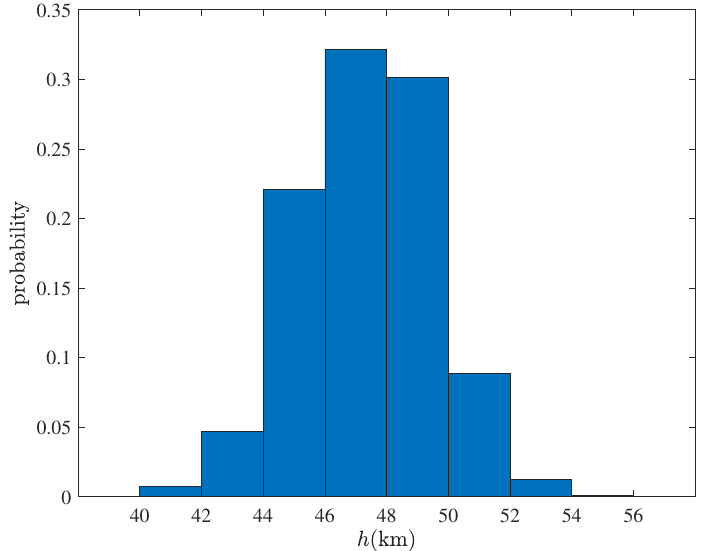
Figure 10. The histogram shows the distribution of altitude during orbit maintenance in the condi- tions of Ω = 240 ◦ , i = 27 ◦ and (cid:107) T (cid:107) = 20 mN. Comparing with the simulation with Ω = 240 ◦ , i = 3 ◦ the altitude of orbit more concentrates in the range from 44 km to 54 km. Due to differences in degree of stability, the effects of orbit maintenance in different inclinations are diverse. As shown in Figure 11, life maintenance time varying with initial inclination is exhibited with Ω = 240 ◦ and (cid:107) T (cid:107) = 20 mN.